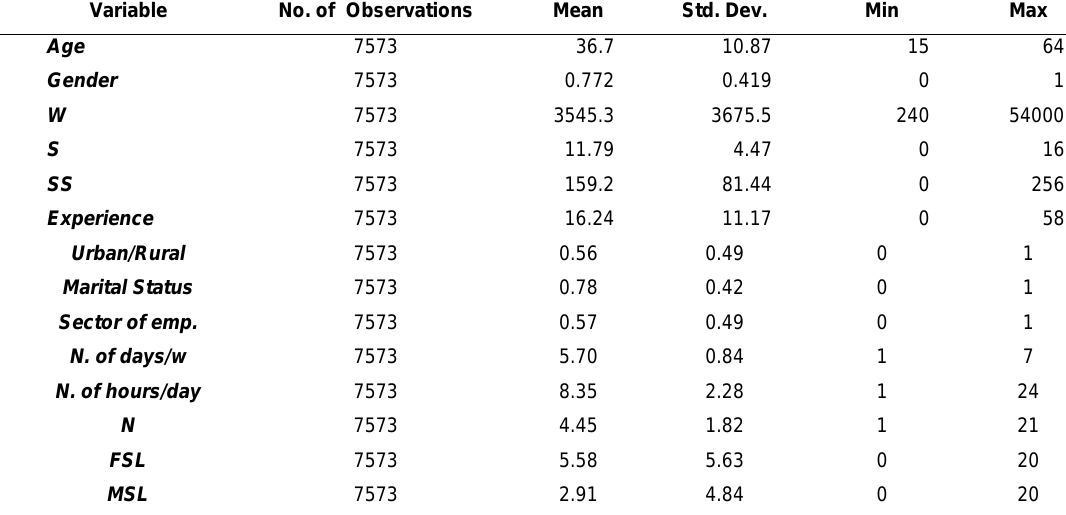
Table 1: Descriptive Statistics of the